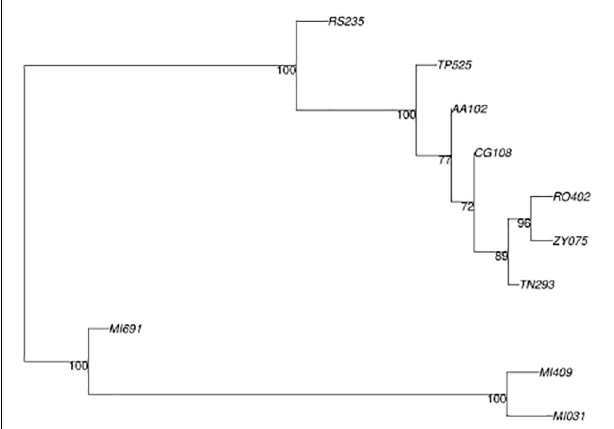
FIGURE 7 | Phylogenetic tree produced by Ape/Phangorn, bootstrap value at